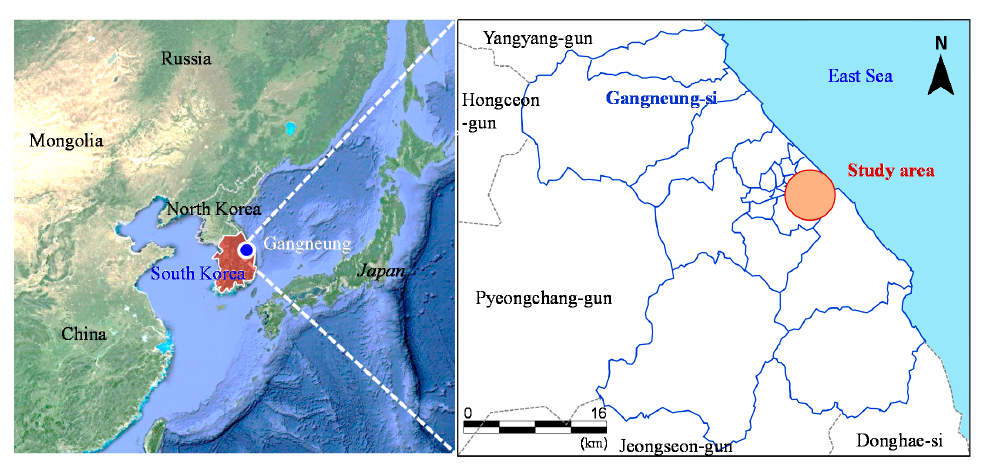
Figure 1. Location of the study area in South Korea.